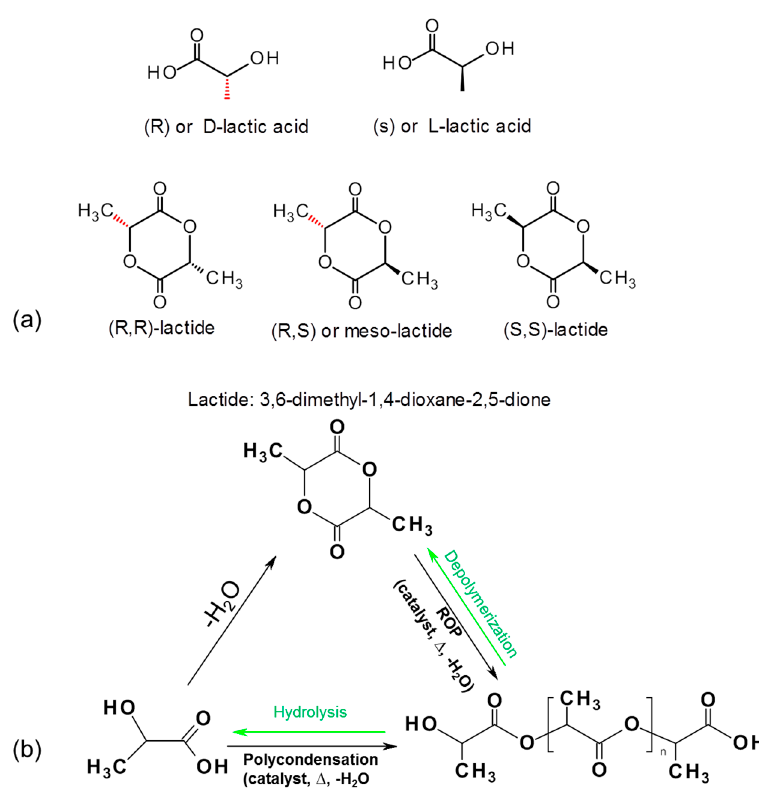
Figure 6. Stereochemistry of the lactic acid (LA) and lactide monomers ( a ) and chemistry of the interconversion between LA, lactide and poly(lactic acid) (PLA) ( b ). Note: Reversible depolymerization and hydrolysis steps are highlight in green color [94].